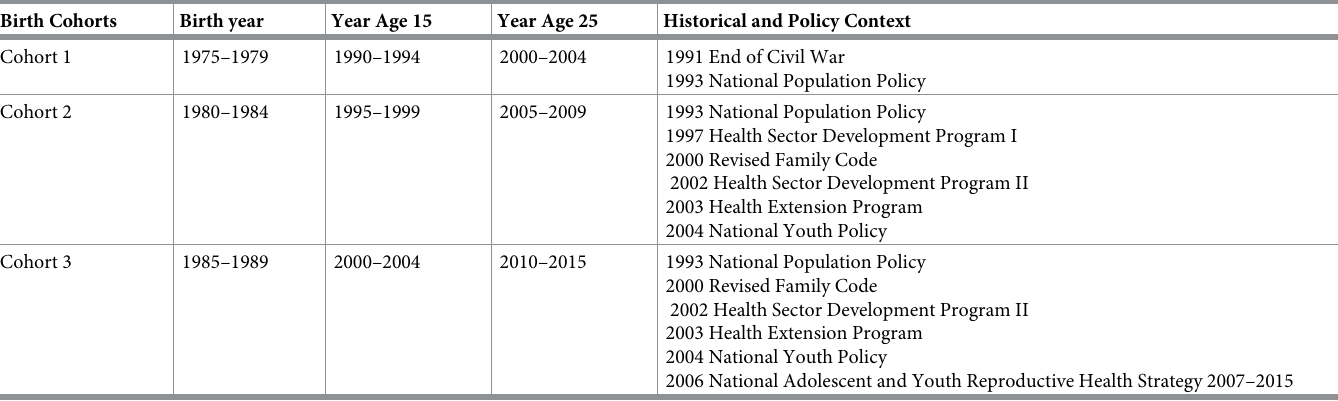
Table 1. Definition of birth cohorts and historical contexts,